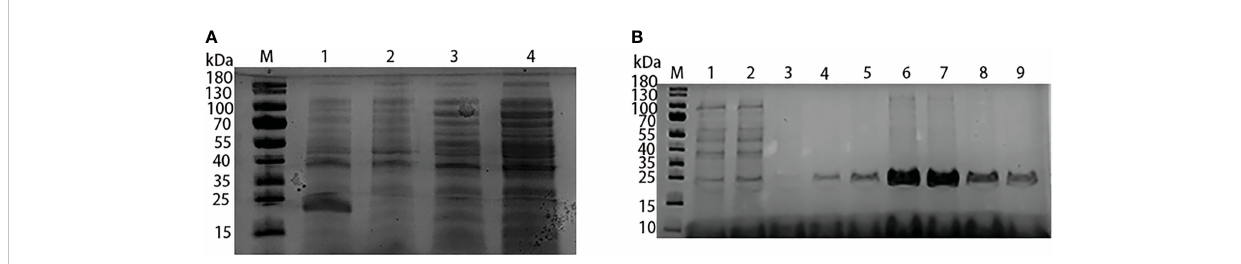
FIGURE 1 Expression and puri fi cation of Lrp recombinant protein. (A) Induced expression of Lrp recombinant protein. M: protein Marker; 1: pET-N-His-C-His- Lrp (induced); 2: pET-N-His-C-His- Lrp (uninduced); 3: pET-N-His-C-His: (induced); 4: pET-N-His-C-His (uninduced). (B) Puri fi cation of Lrp recombinant protein Situation. M: protein Marker; 1-2: fl ow-through solution; 3-5: washing solution; 6-9: elution